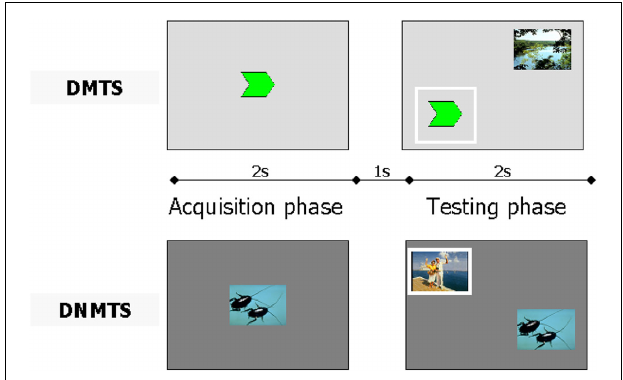
FIGURE 1 | Experimental design using a single trial for delayed matching to sample (DMTS) and another for delayed non-matching to sample (DNMTS). The full procedure included 48 trials for each condition. Each condition was performed with the same parameters. In the acquisition phase, the sample was presented for 2s followed by presentation of a pair of pictures (sample included) for 2s in the testing phase, intercalated by a 1-s delay.The participant had to click on the sample picture in acquisition phase, and thereafter, in testing phase, click on the same picture for the DMTS condition, or on the novel picture for the DNMTS condition.The correct response is outlined in